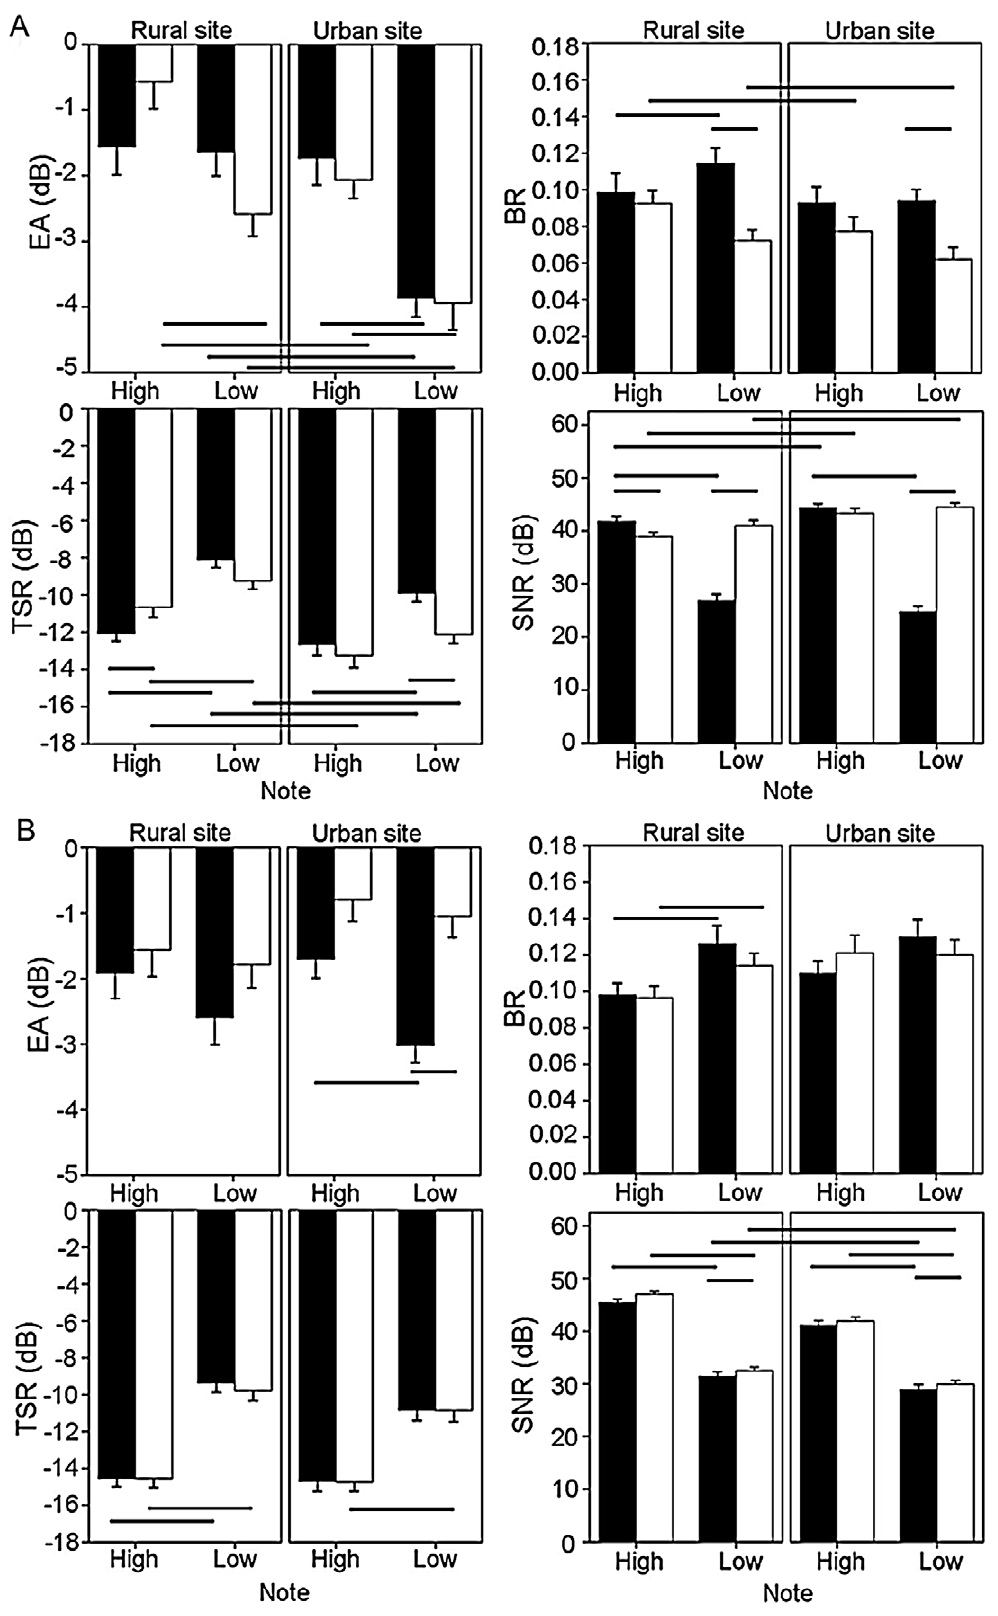
Figure 4. Effect of note on the four degradation measures. (a) experiment 1, rural and true urban song and (b) experiment 2, rural and artificial urban song. Black bars are rural song, white bars are urban song. Error bars denote one standard error of the mean. Significant differences are indicated with black lines below (EA: Excess attenuation and TSR: Tail-to-signal ratio) and above (BR: Blur ratio and SNR: Signal-to-noise ratio) the bars. PLoS ONE |